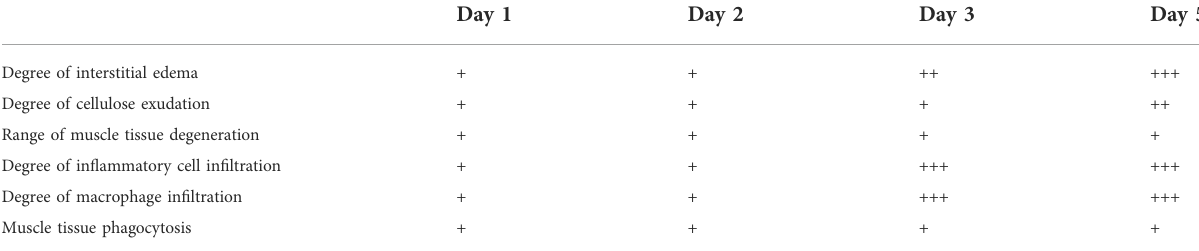
TABLE 1 Pathological comparison of muscle injury at different times. [Relevant evaluation criteria were based on the method described previously (Wu et al.,